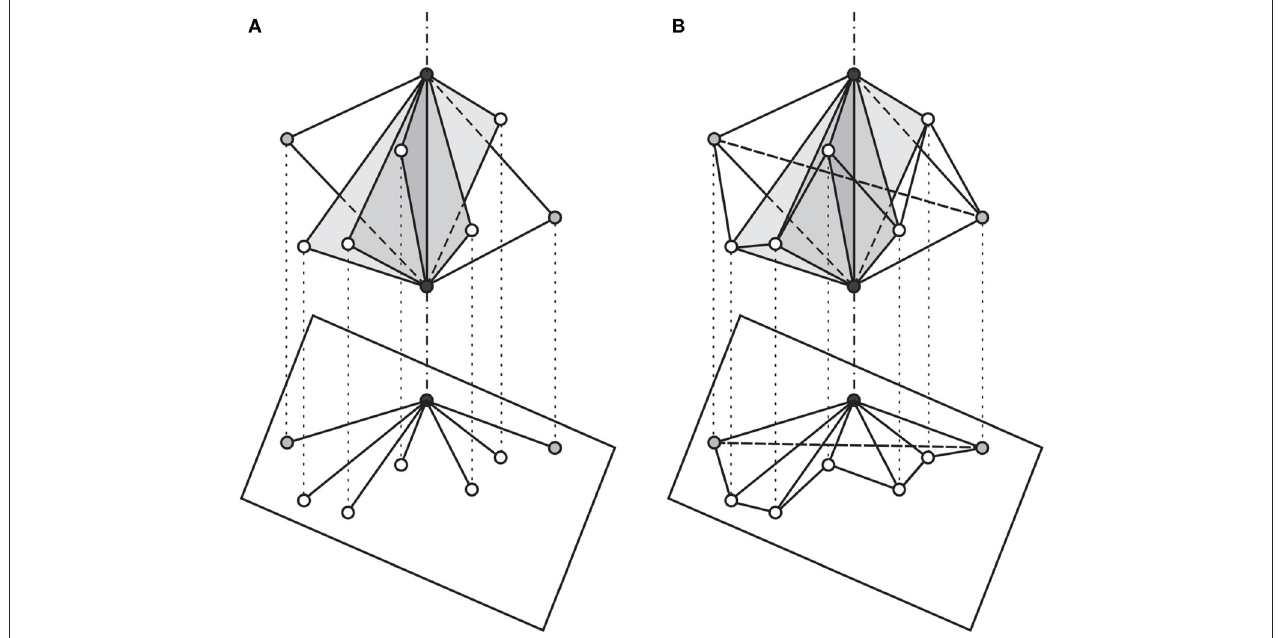
FIGURE 13 | Two phases, (A) and (B) , of the Construction of a three-dimensional Grünbaum framework, and the corresponding projection onto a nonconvex Grünbaum polygon (see description in Section